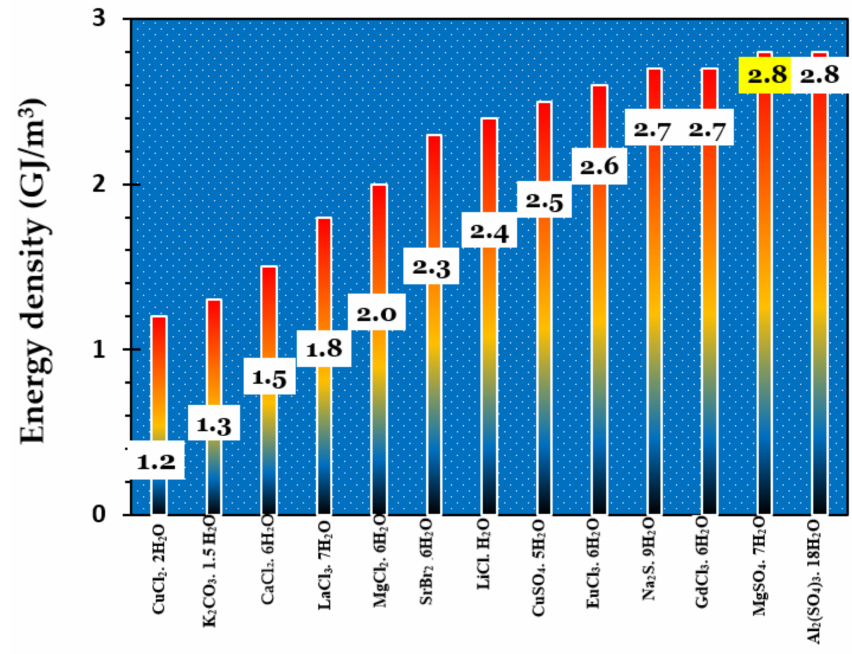
Figure 5. Energy densities of pure salt for the TCES system